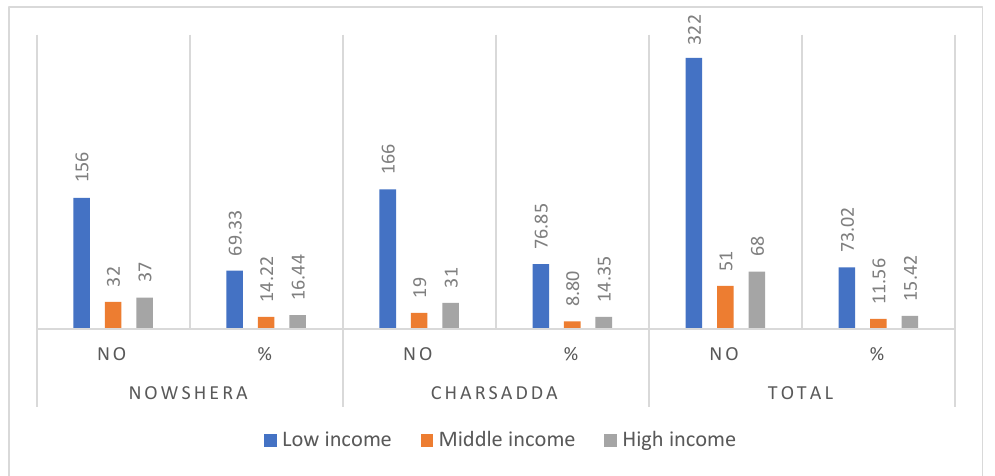
Figure 6. flood risk perception varies based on the household head age.